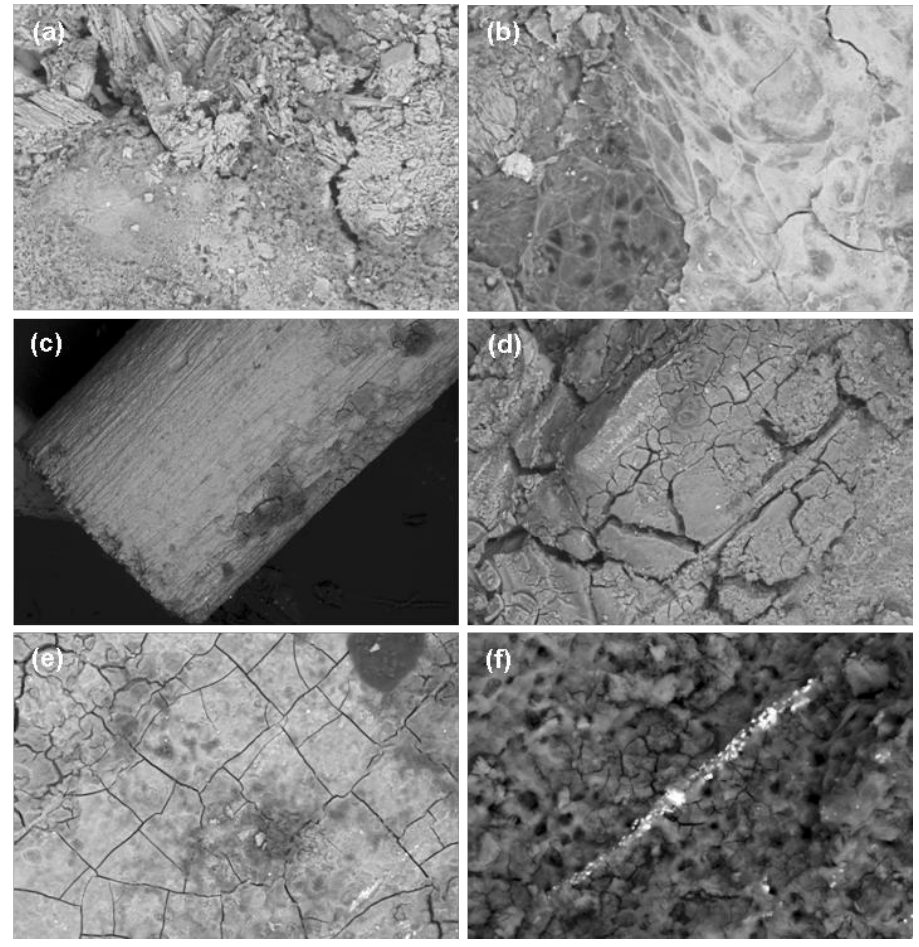
Figure 5. Scanning electron microscopy images of implants after explantation.